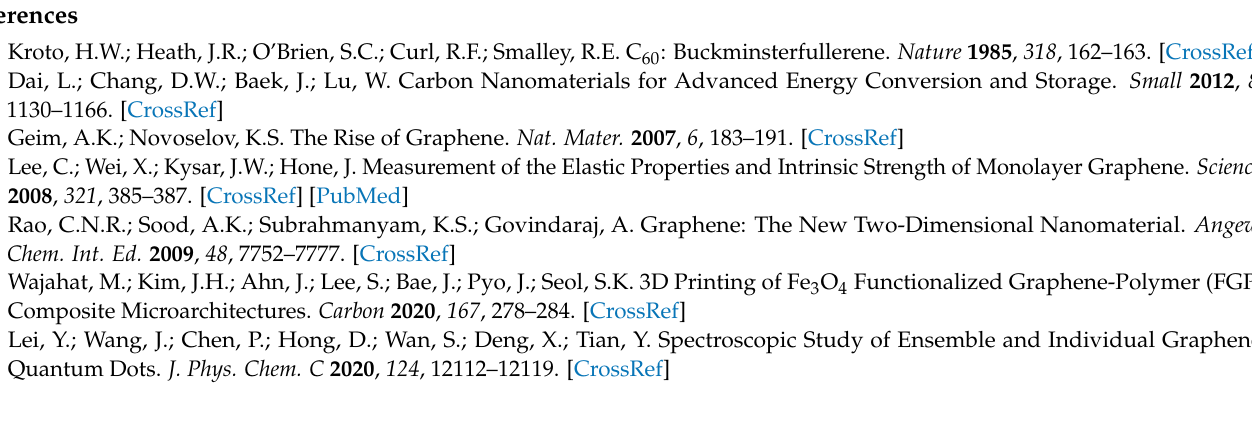
Table S1: The main parameters of the UT-FVP apparatus; Table S2: The parameters of the mass spectrum; Table S3: The parameters of HPLC; Figure S2: The heating rate of the UT-FVP apparatus; Figure S3: The HPLC-MS chromatogram of the product from the pyrolysis of CHCl 3 at 1100 ◦ C and 1200 ◦ C using traditional FVP apparatus; Figure S4: The HPLC-MS chromatogram of the product from the pyrolysis of CHCl 3 at 1530 ◦ C using inert gas N 2 (red line) and He (blue line), respectively; Figure S5: Variation of C 60 product concentration with vacuum pressure of reaction system. The red line means that the inert gas (N 2 was used in the pyrolysis reaction, and the blue line means that the inert gas He was used in the pyrolysis reaction; Figure S6: The standard curve (red) of the UV (330 nm) chromatogram of C 60 and the experimental data of CHCl 3 (blue); Figure S7: Experimental and theoretically simulated mass spectra of the soot products; Figure S8: The HPLC-MS chromatograms of the soot products from the pyrolysis of the graphite tube at variable pyrolysis temperatures from 2400 ◦